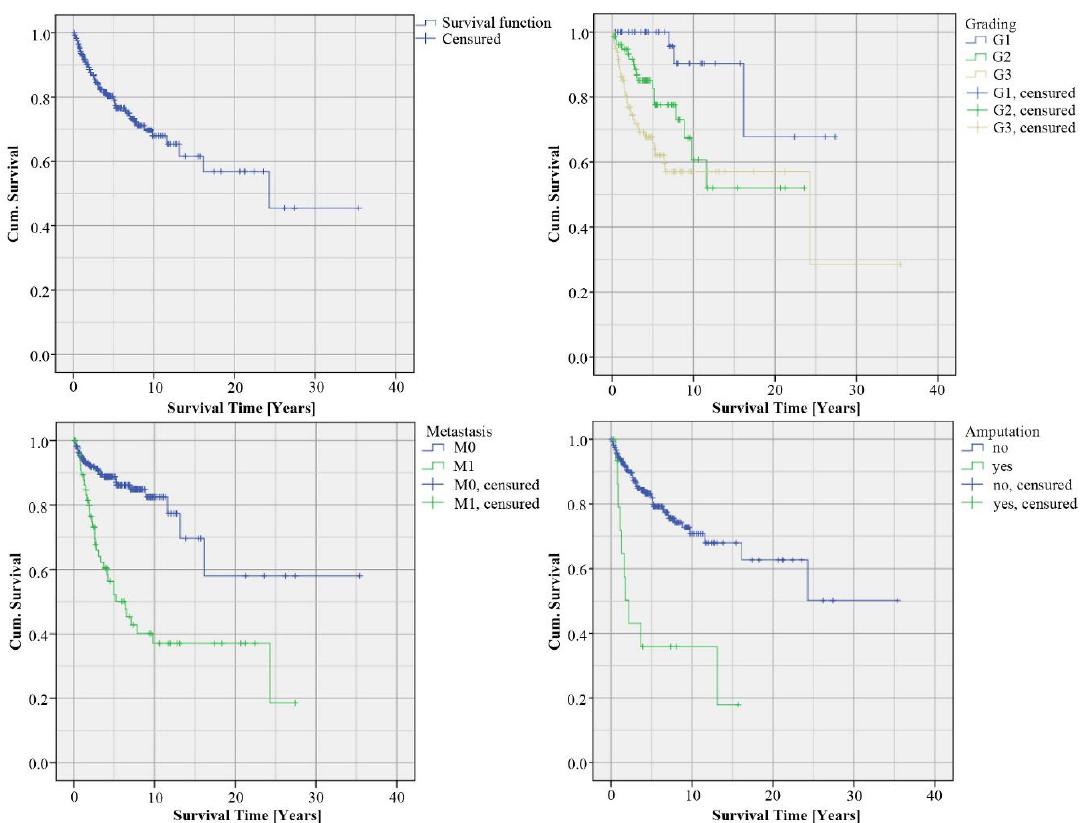
Table 3. Univariate Cox regression of cumulative survival according to Figure 1. HR = Hazard Ratio, CI = Confidence Interval. * p ≤ 0.05.